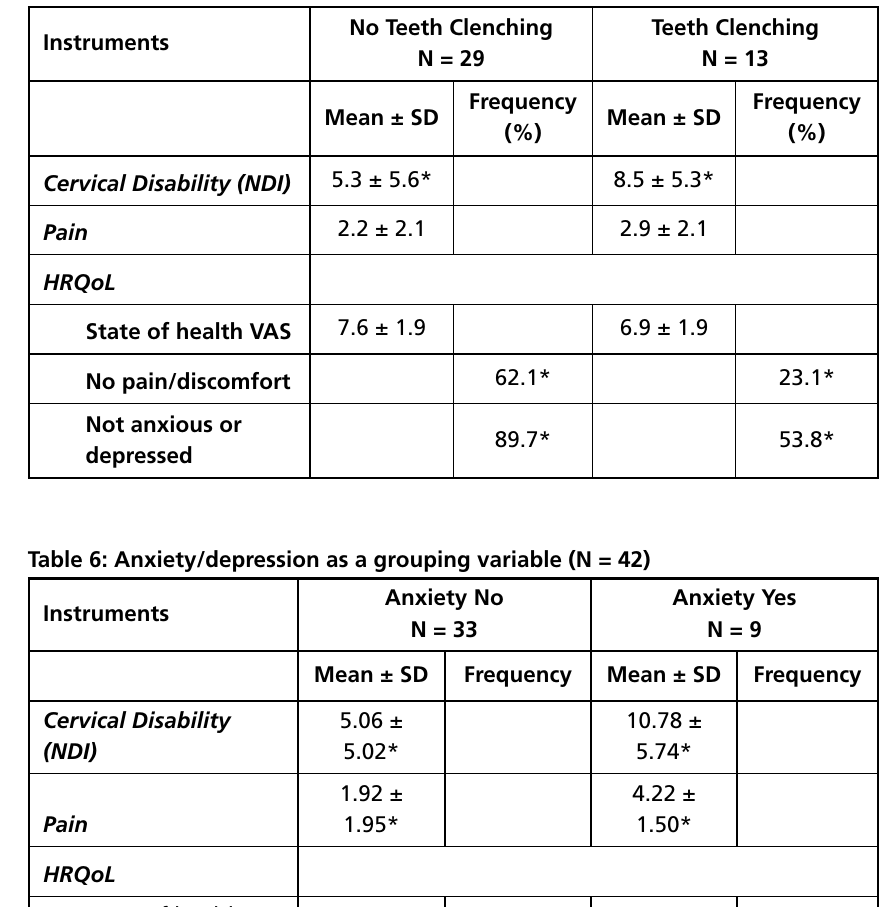
table 5: Daytime teeth clenching as a grouping variable (n = 42)